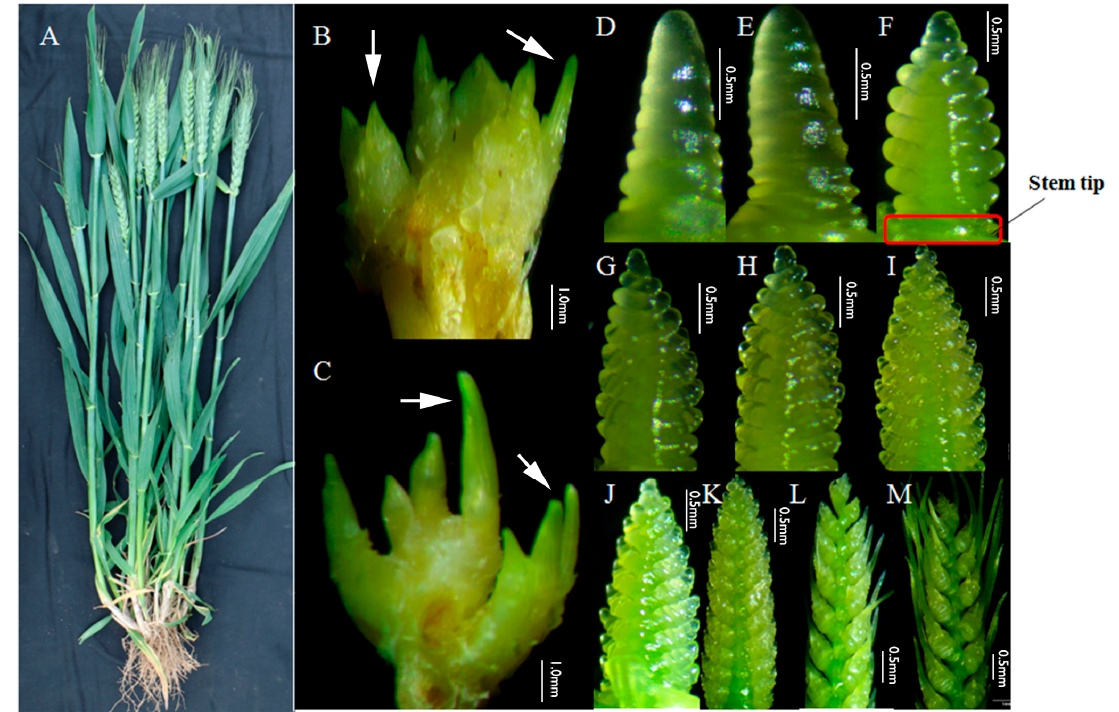
Figure 1. The plant, tillers, and young spikes of Guomai 301. ( A ) An individual plant of Guomai 301 in the field condition; ( B , C ) tiller primordia at three-leaf stage and four-leaf stage, arrow heads indicated the small tillers; (D-M), spikes at various developmental stages; ( D ) single ridge stage; ( E ) double ridge stage; ( F ) glume primordia visible; ( G ) lemma primordia visible; ( H ) floret primordia visible; ( I ) late terminal spikelet; ( J ) terminal spikelet stage; ( K ) two awns/spikelet reaching apical meristem of the spikelet; ( L ) two awns/spikelet twice as long as spikelet; ( M ) elongation of third awn/spikelet, basal